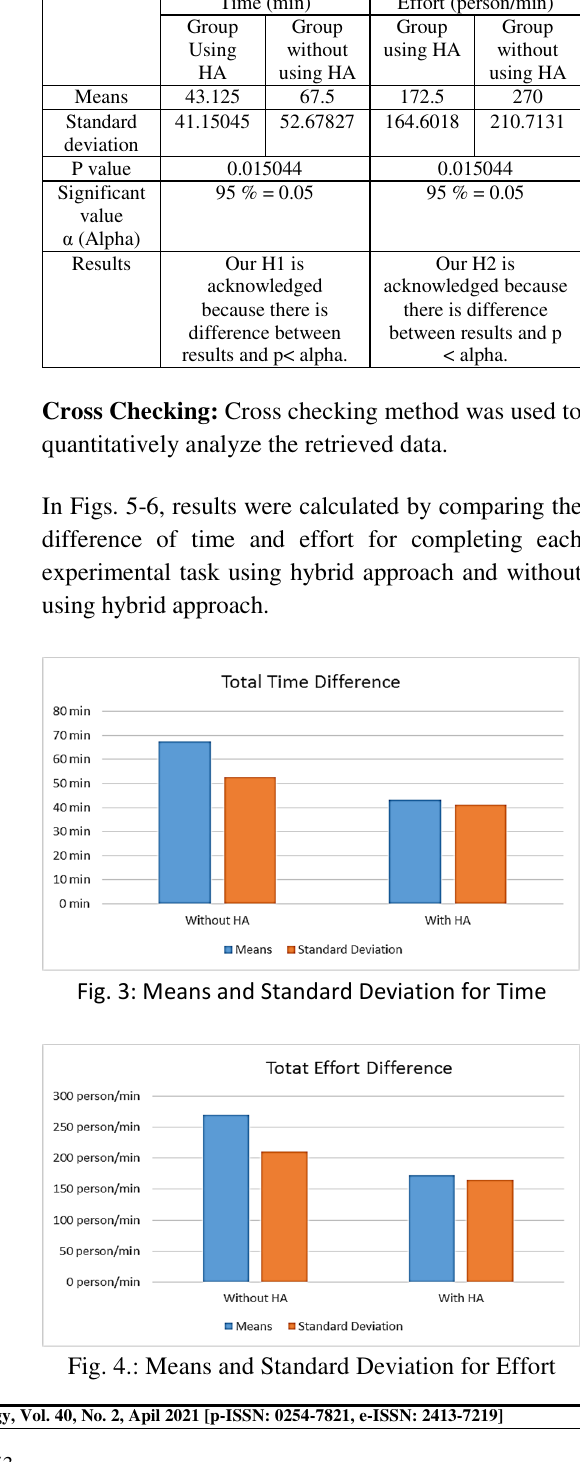
Table 4: T-Test Results